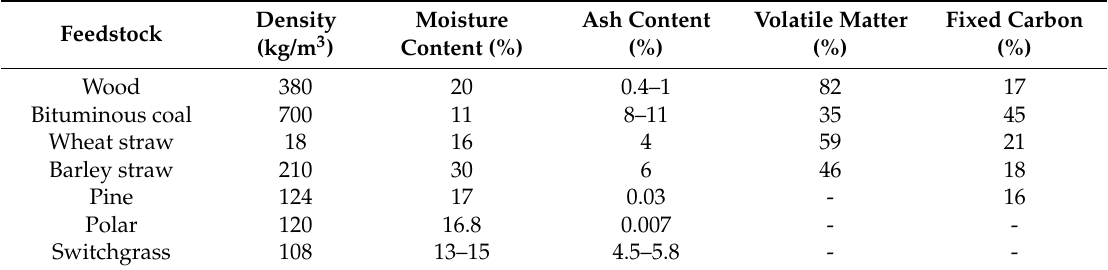
Table 1. Physical characteristics of biomass [9].